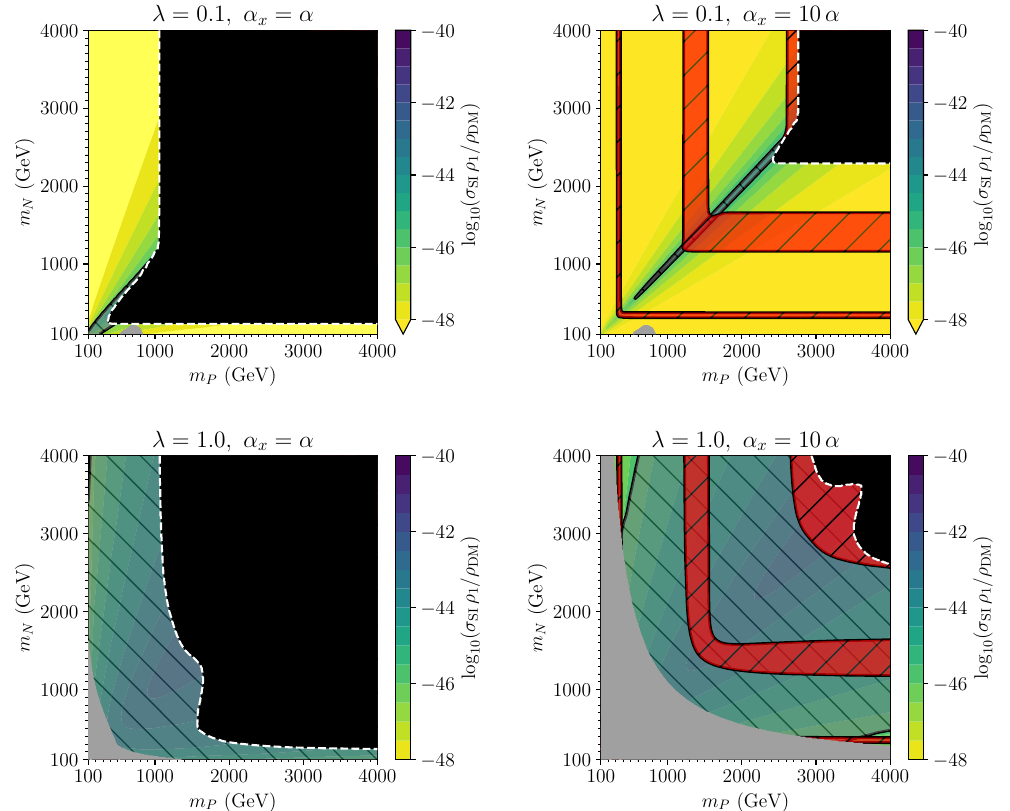
Figure 4 . Contours of the density-weighted spin-independent per nucleon cross section σ SI ρ 1 /ρ DM for the Majorana extended theory in the m P – m N plane for λ = 0 . 1 , 1 . 0 (top and bottom) and α x = α, 10 α (left and right). The downward hatched regions are excluded by DM direct detection searches, while the red upward hatched regions are ruled out by indirect detection tests. Also, the grey shaded regions show the combined exclusions from direct searches, and the black regions indicate where ψ 1 produces too much thermal dark −